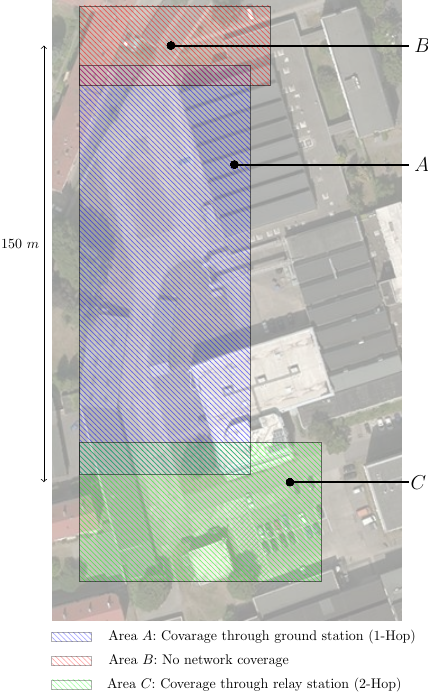
Figure 5. Experiment